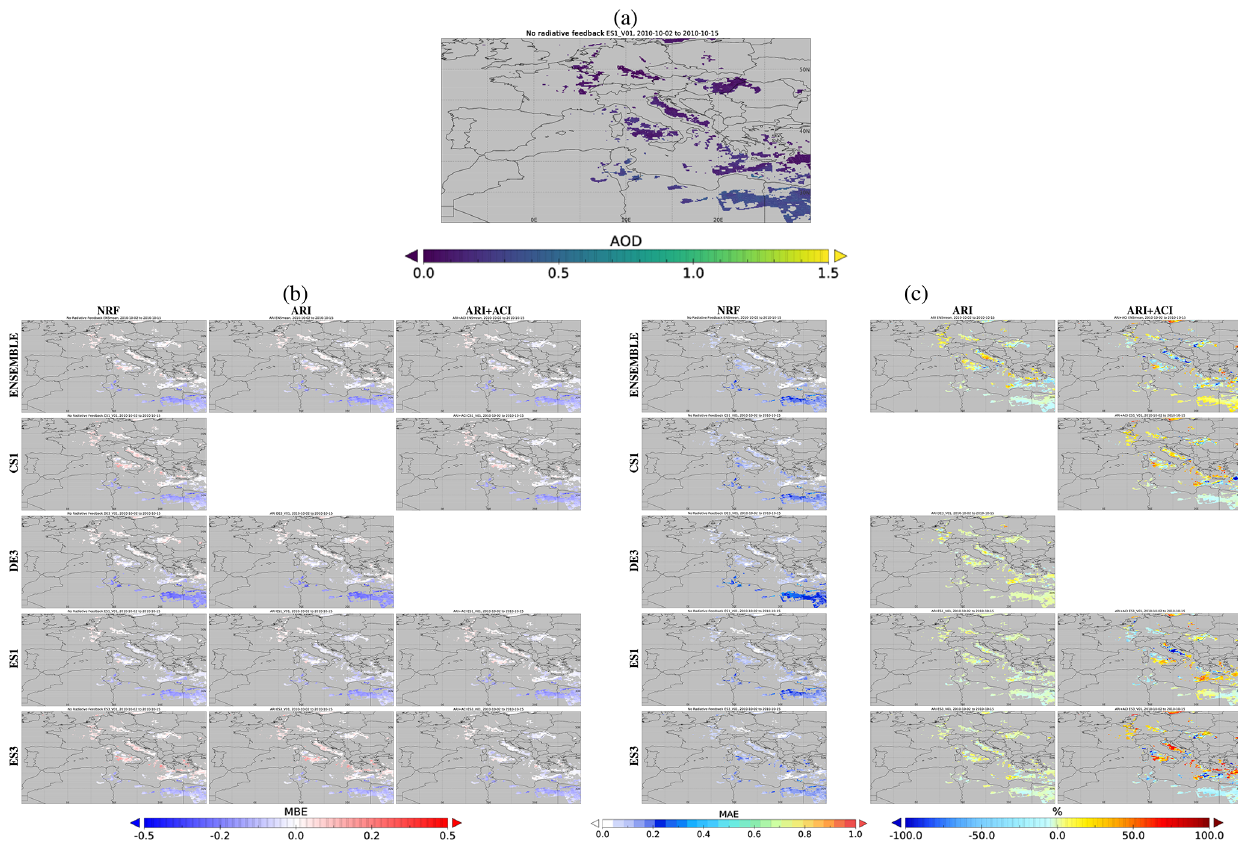
Figure 6. Model-MODIS comparison of AOD at 550nm for the Saharan desert dust outbreak case: (a) satellite values; (b) MBE for NRF (first column), ARI (second) and ARI + ACI (third); and (c) MAE for the NRF simulations (first column) and their improvements due to ARI (second) and ARI + ACI